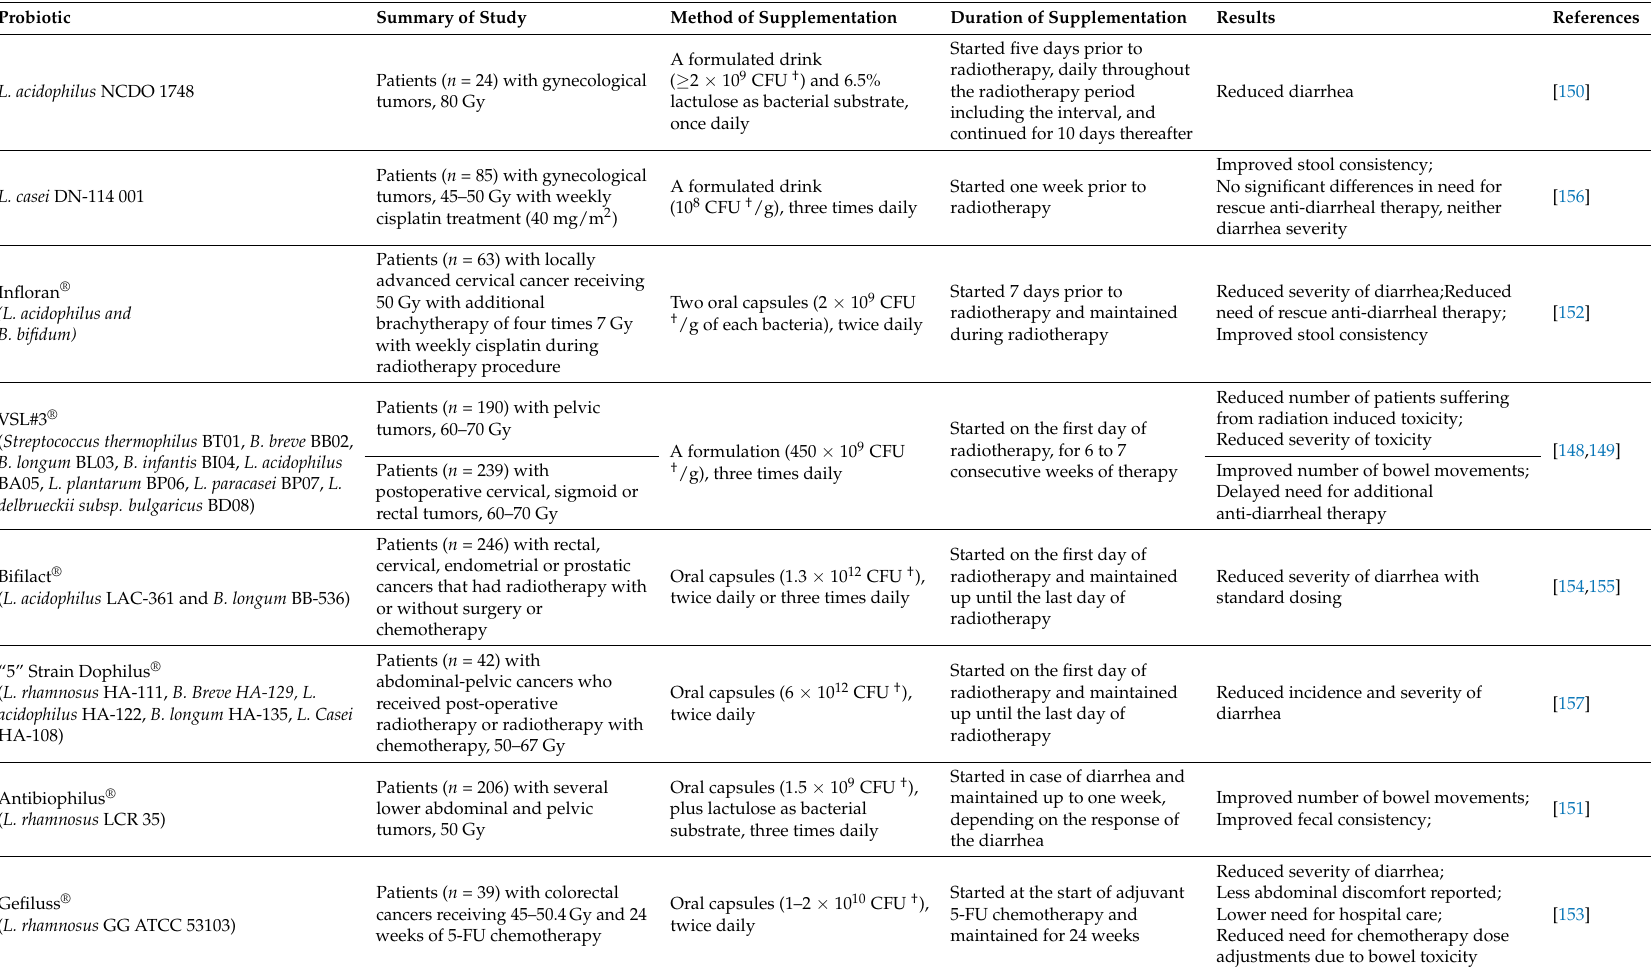
Table 3. Overview of clinical studies on probiotic strategies for treating radiation induced gastrointestinal toxicity in cancer